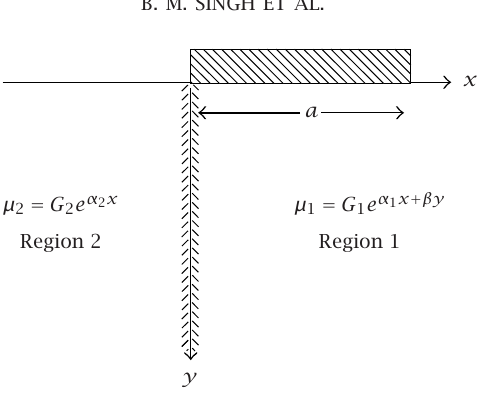
Figure 3.1 . Contact problem for bonded nonhomogeneous